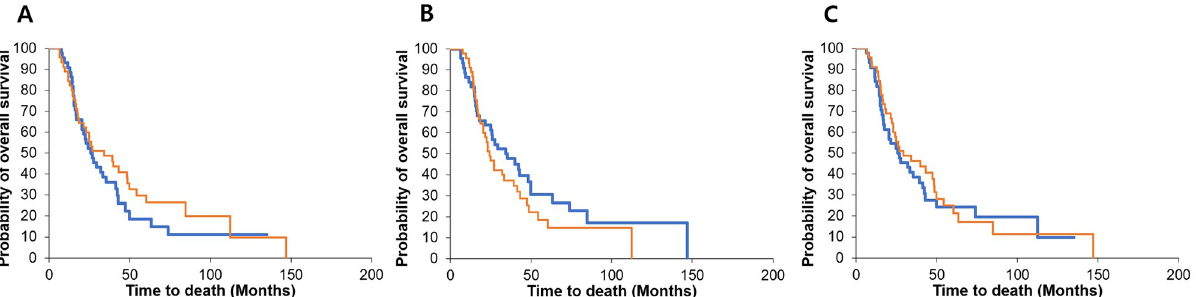
Fig 1. Survival according to the body mass index (BMI), skeletal muscle mass (SMM), and visceral fat mass (VFM) before resection. The Kaplan– Meier analysis found no significant difference in the overall survival (OS) according to the BMI, SMM, and VFM before resection. The orange and blue lines indicate the higher and lower groups, respectively. (A) BMI before resection ( P = 0.311), (B) SMM before resection ( P = 0.234), and (C) VFM before resection ( P = 0.667).